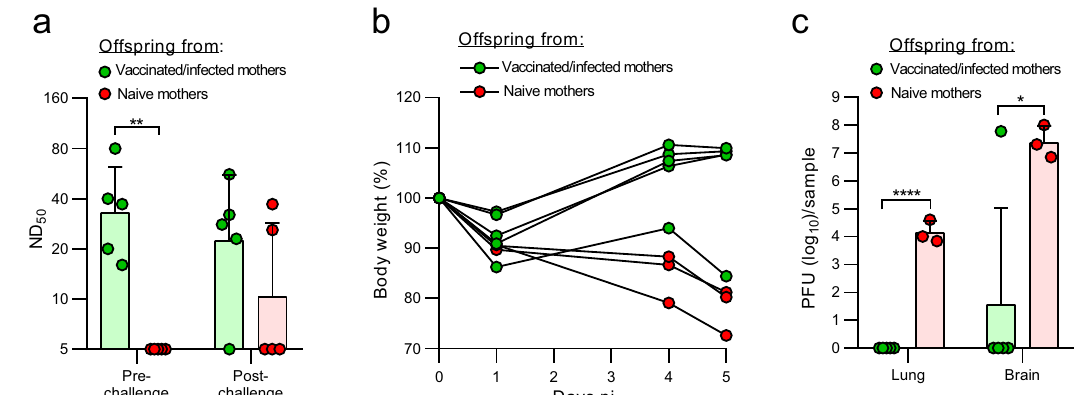
Fig. 5 Maternal antibodies protect offspring from lethal SARS-CoV-2 infection. Six-week-old offspring of naïve (red) or of immunized and subsequently infected with SARS-CoV-2-S D614G (green) K18-hACE2 mice were challenged intranasally with 3 × 10 4 TCID 50 SARS-CoV-2-S D614G . a Determination of virus neutralization titers (ND 50 ) in serum of offspring 1 week before and 5 days after challenge infection. b Body weight at the indicated times pi. c Determination of infectious SARS-CoV-2 titers in lung and brain tissue homogenates 5 days pi. Geometric means and geometric SD are indicated. Statistically signi fi cant differences were determined by the two-way ANOVA test ( a ) or by the two-tailed unpaired Student ’ s t test ( c ) (* p < 0.05; ** p < 0.005, **** p <